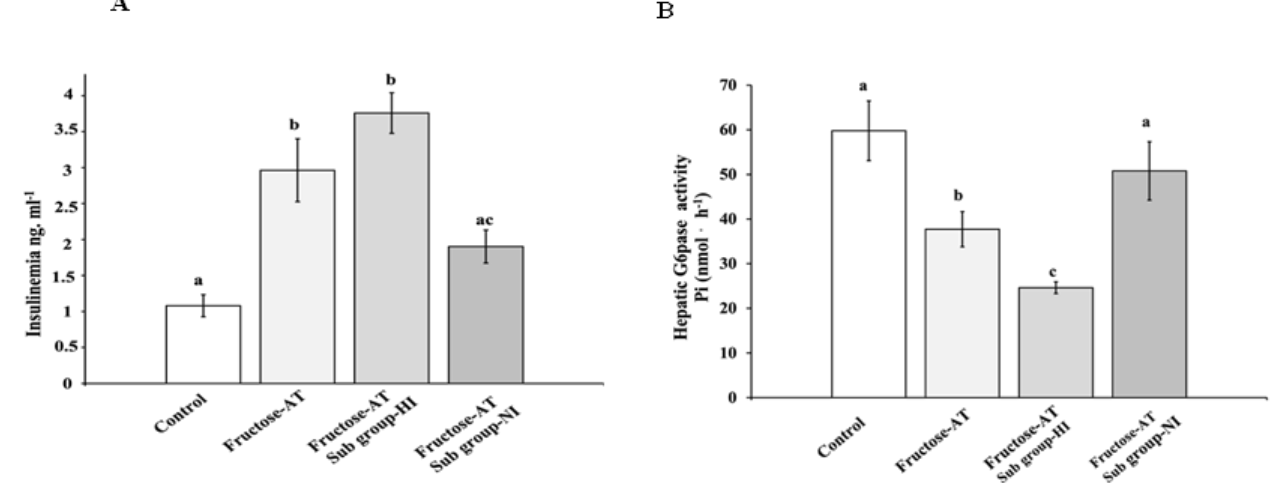
Figure 5. Specific analysis of the two subgroups of the Asteraceae infused drink. ( A ) Insulinemia; ( B ) Hepatic glucose-6-phosphatase activities. Subgroup-HI (high insulinemia) ( n = 5); subgroup-NI (normal insulinemia) ( n = 3). Different letters (a, b and c) indicate significantly differences from each ( p < 0.05).